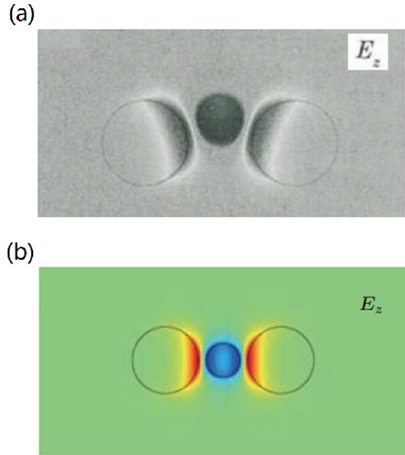
Figure 8. Field distributions (E z ) of the lowest-order mode in non-coplanar ( a ) and coplanar ( b ) GCNW trimers. ( a ) Reprinted with permission from reference [90]. Copyright Chinese Laser Press, 2019. ( b ) Reprinted with permission from reference [91]. Copyright Chinese Physical Society, 2018.